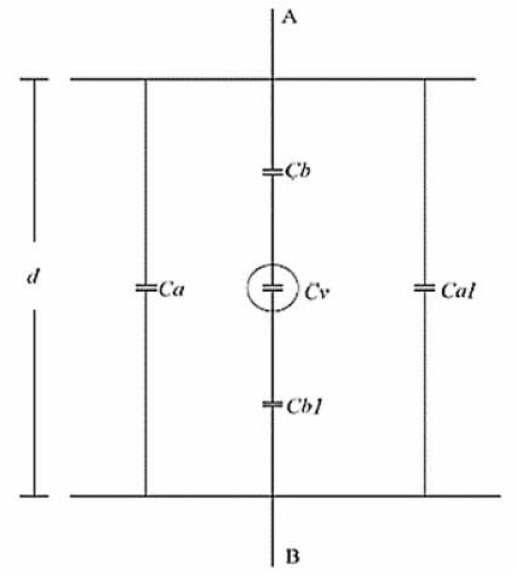
Figure 4. Equivalent circuit of PD